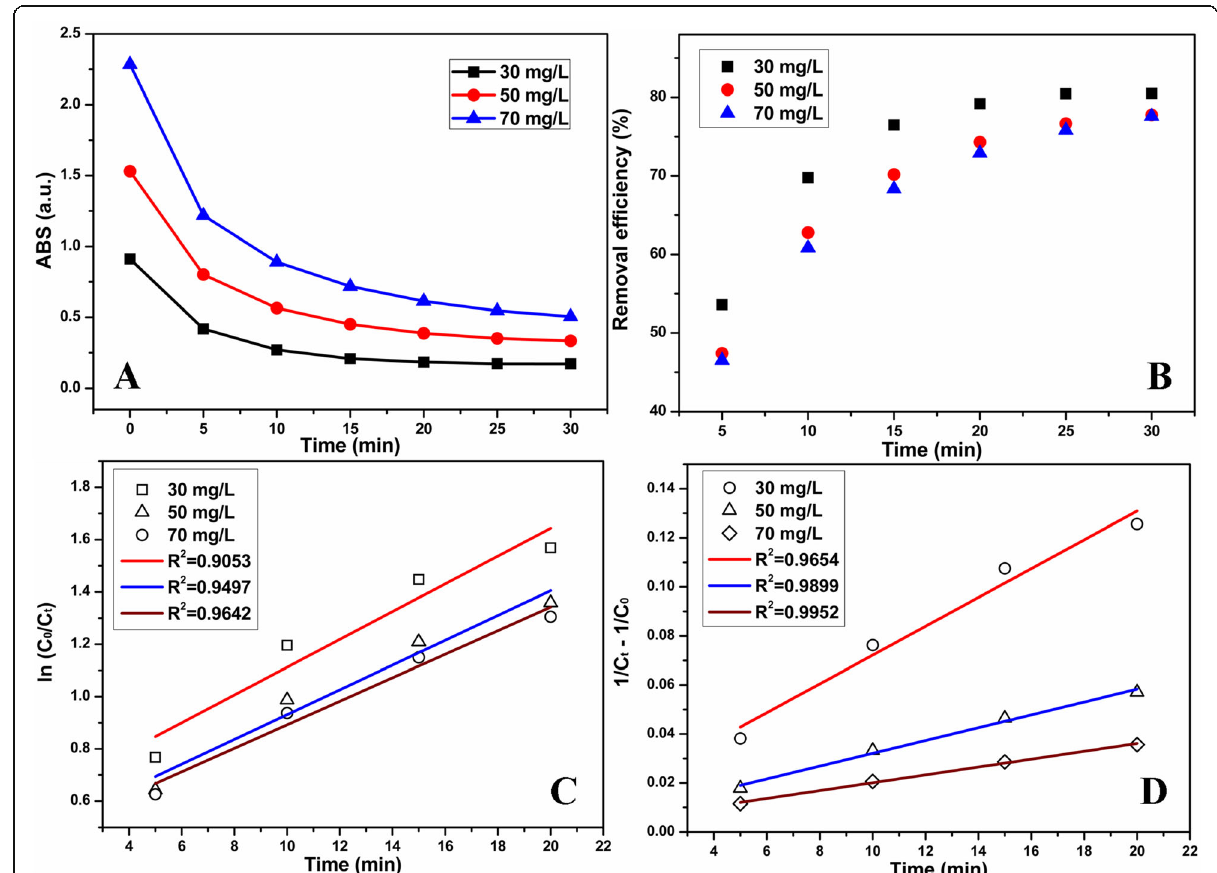
Fig. 7 The time-dependent a absorption intensity of TCH and b removal efficiency for the degradation of different initial concentrations of TCH. c Linear first-order kinetic plots and d linear second-order kinetic plots for degradation of different initial concentrations of TCH. (Conditions: a dose of MnO 2 NPs/ESM was 0.1740 g/L, controlled pH was 3.0)